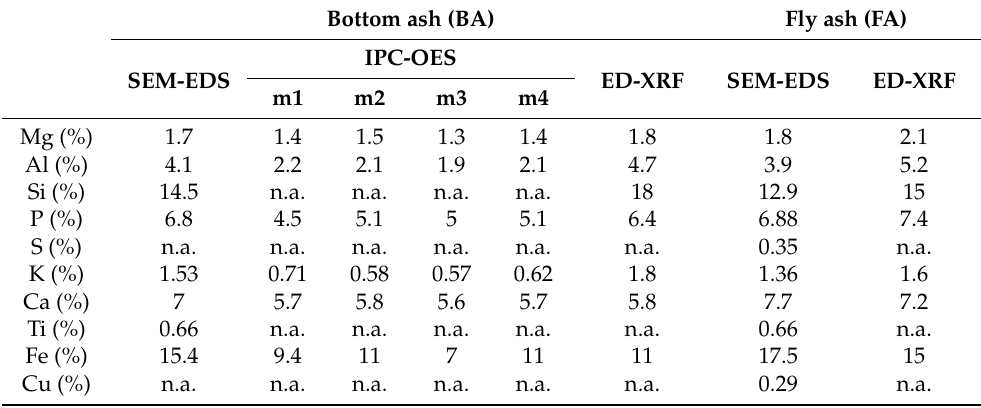
Table 1. Elements constituting BA and FA. n.a.: not available. Bottom ash (BA) Fly ash (FA) IPC-OES SEM-EDS